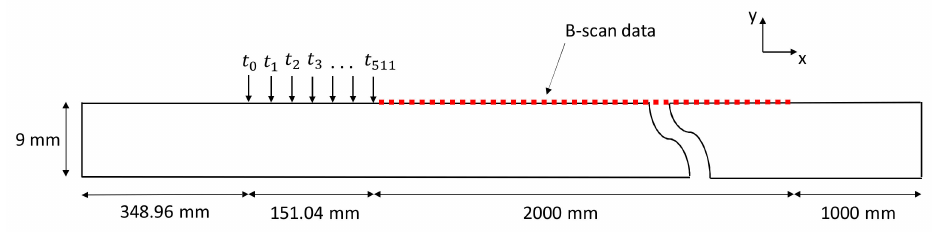
Figure 6. FE model setup of unrolled pipe. t 0 – t 511 indicates different excitation delays provided to nodes of